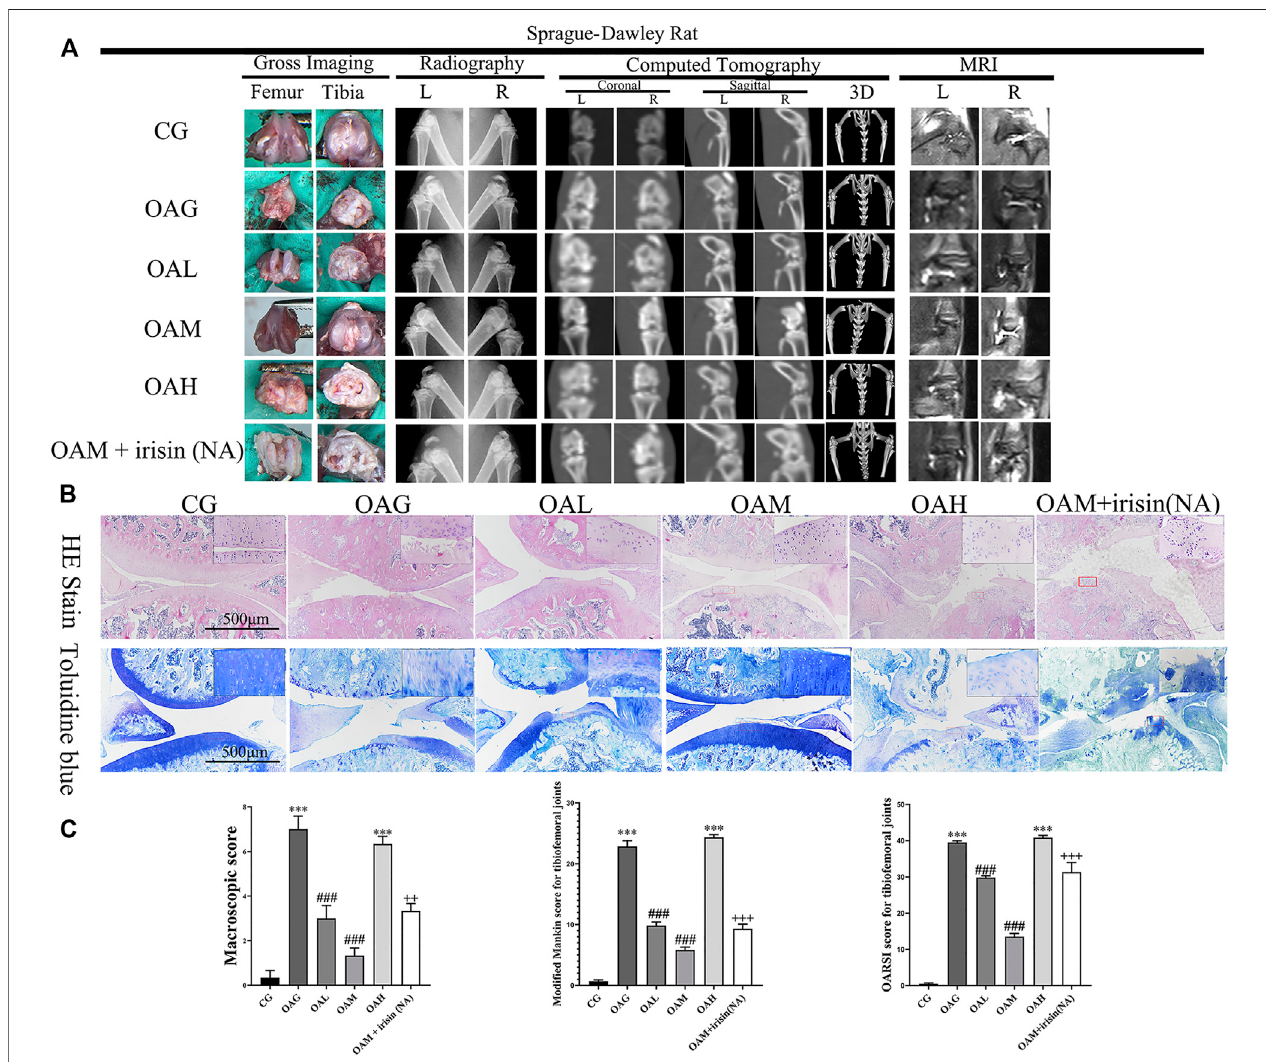
FIGURE 3 | Histological evaluation and imaging examination of tibiofemoral joints of OA rats under different treadmill exercise protocols. OA model was con fi rmed usingplainradiography, computedtomography(CT),andmagneticresonanceimaging(MRI) (A) .Histologicalanalysiswasevaluatedusinghematoxylinandeosin(H&E) andtoluidineblue (B) staining.Weobservedincreasedsurfaceroughening, fi brillation, fi ssures,anderosionsdowntothesubchondralboneinOAGandOAHcompared with CG. A relatively smoother and complete articular cartilage surface was observed in OAM compared with OAG and OAH. However, the therapeutic effects of moderate-intensitytreadmillexercisecouldbesuppressedbyirisinneutralizingantibodies. (C) Modi fi edMankinscorefortibiofemoraljoints.OARSIscorefortibiofemoral joints. Data were expressed as the mean ± SEM. * p < 0.05 vs. CG; ** p < 0.01 vs. CG; *** p < 0.001 vs. CG. # p < 0.05 vs. OAG; ## p < 0.01 vs. OAG; ### p < 0.001 vs. OAG. + p < 0.05 vs. OAM; ++ p < 0.01 vs. OAM; +++ p < 0.001 vs. OAM. n = 5, means ±95% CI.